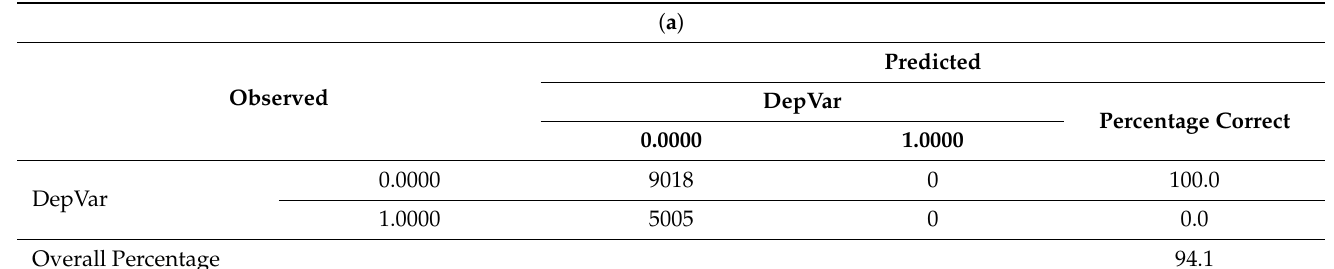
Table 3. (a) Knowledge model: classification table; (b) Knowledge model: test results; (c) Creativity model: classification table; (d) Creativity model: test